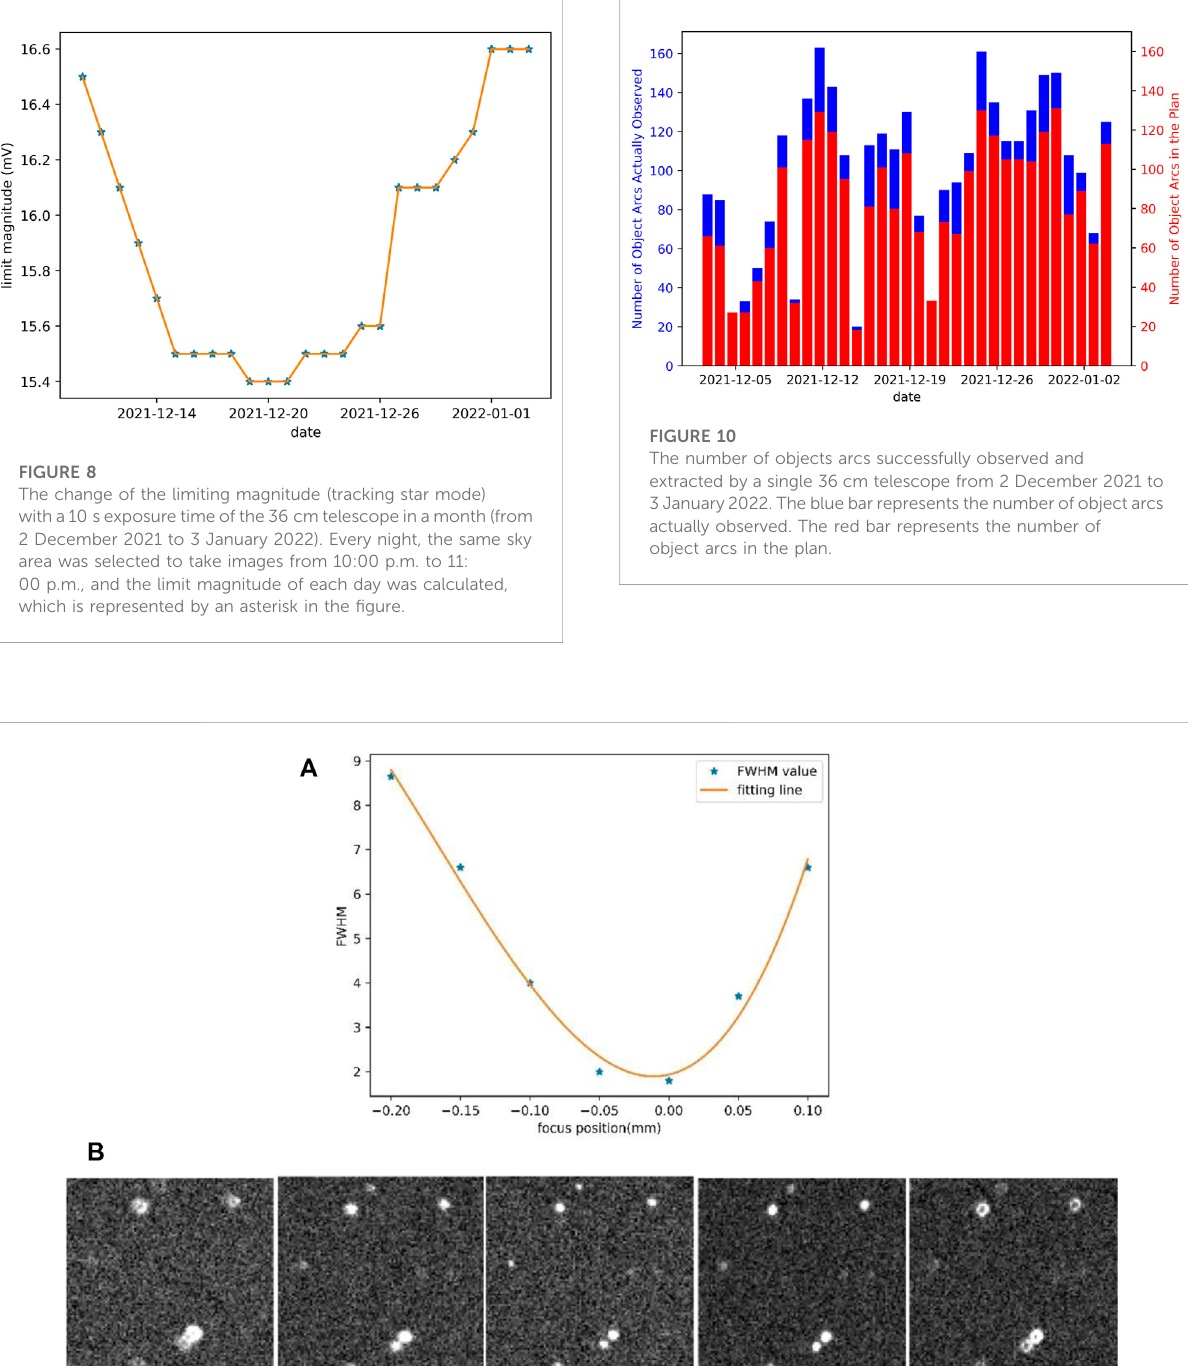
FIGURE 9 The result of FWHM curve fi tting using the V-curve method. (A) Diagram of curve fi tting. The X-axis is the focal position and Y-axis is the mean FWHM value of the image. (B) The sequence of images on different focal position.